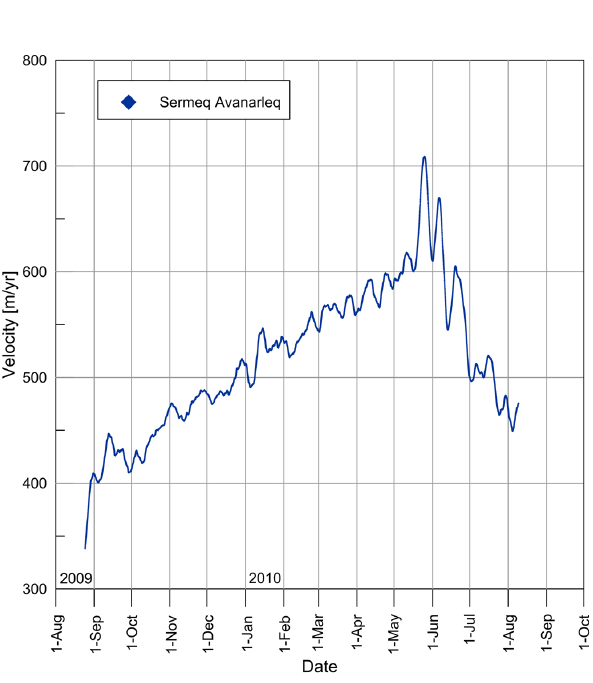
Figure 5. Sermeq Avanerleq 7-day averaged GPS velocities (see Fig. 1 and Table 1 for instrument position and operational